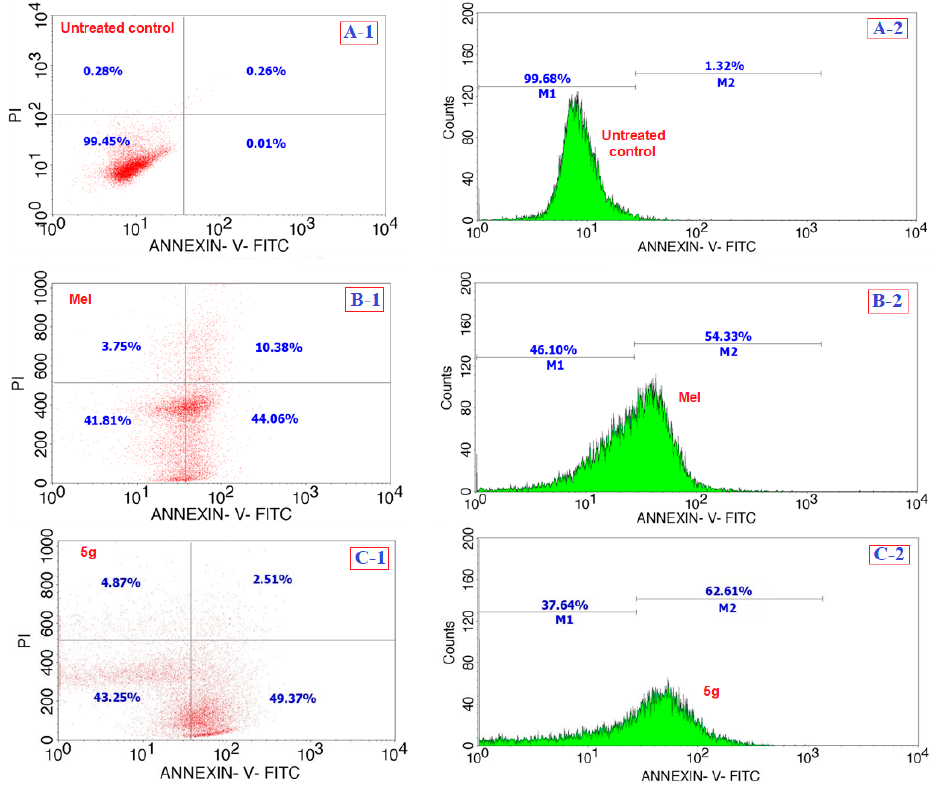
Figure 4. Comparison of the apoptosis assay results of the testing compound 5g ( C ) with those of the positive control Mel ( B ), and the negative control of cells without any treatment ( A ) over a period of 24 h.